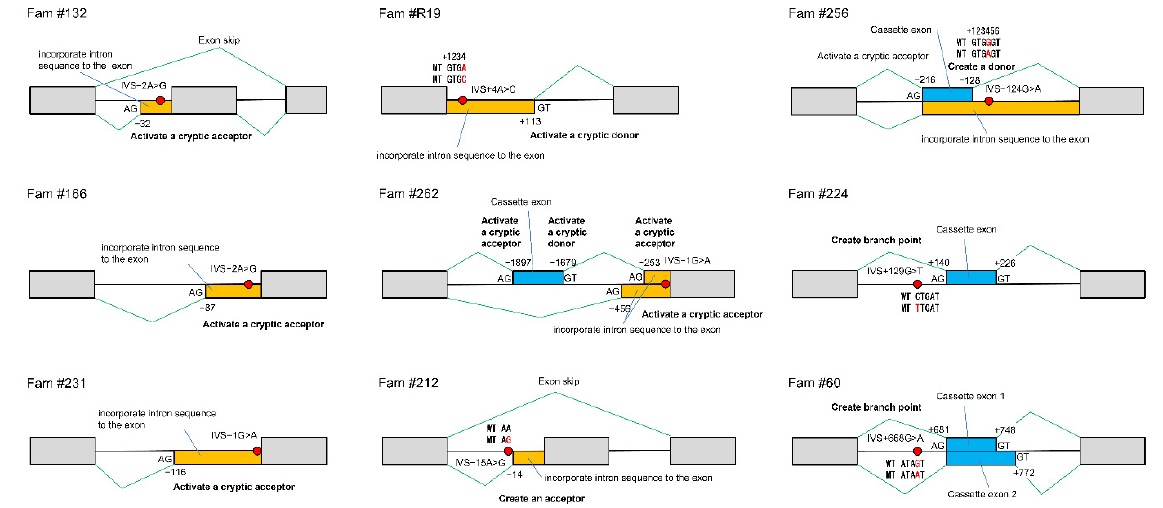
Figure 7. The consequences of complex splicing mutations. WT: wildtype allele sequence; MT: mutation allele sequence.